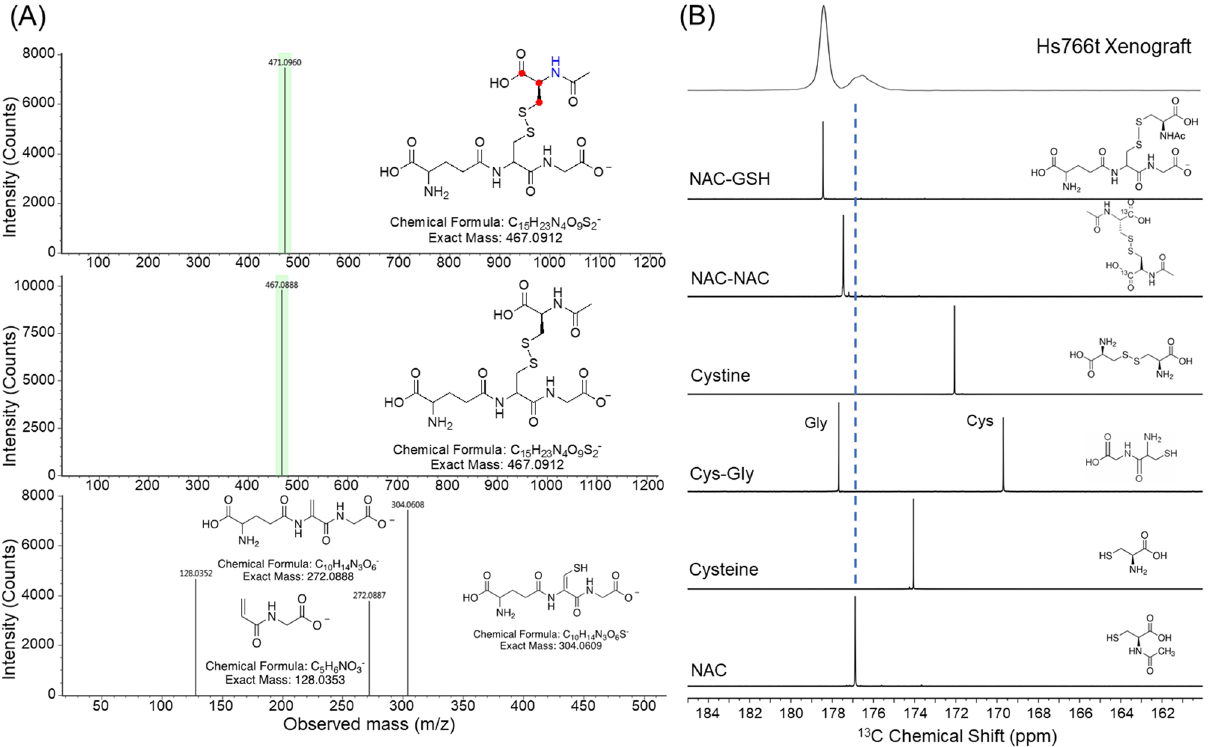
Figure 3. Identification of products from hyperpolarized [1- 13 C] NAC. ( A ) ESI–MS spectra of SU.86.86 tumor extracts with (top) and without (middle) isotope labeling in NAC. 13 C labeled atoms are indicated in red, 15 N labeled atoms are indicated in blue in the NAC-GSH structure. High energy ESI–MS spectrum of NAC-GSH with possible fragment identifications (bottom). ( B ) 13 C NMR spectra of synthesized model compounds at 400 MHz, pH 7.5 that represent potential products in comparison to the spectrum from the hyperpolarized [1- 13 C] NAC MRS experiments in Hs766t tumor xenograft at 20 s after the iv injection